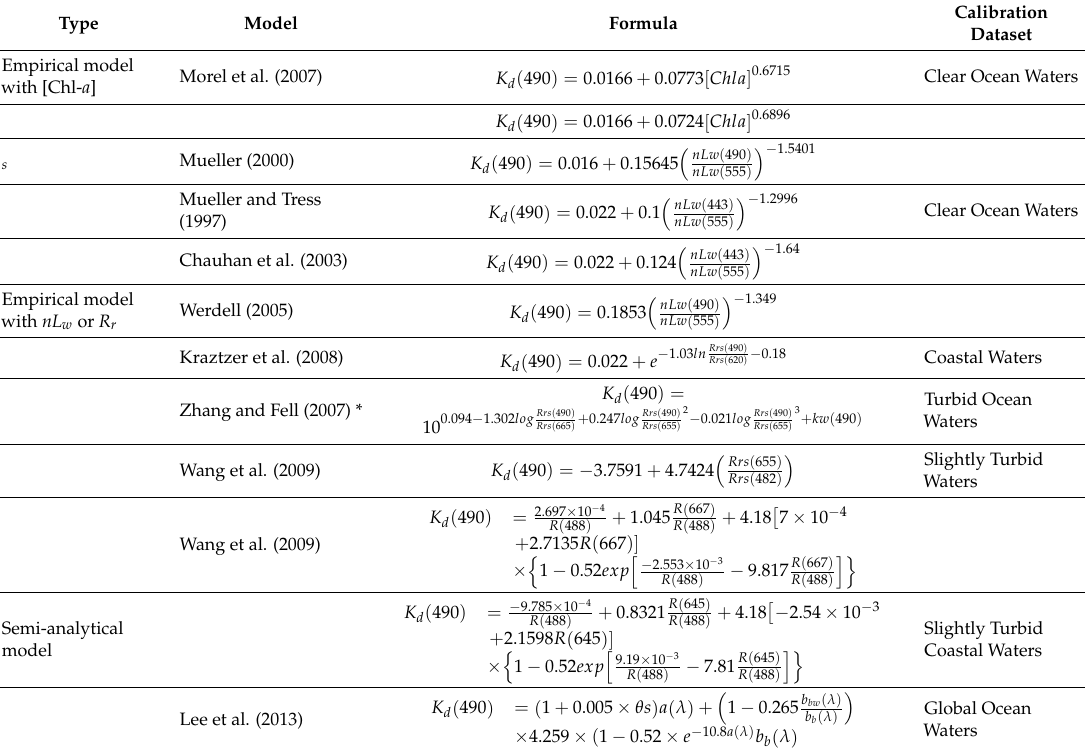
Table 1. k d (490) models developed for clear ocean, coastal, turbid ocean, slightly turbid, and global waters. Although the models were developed to retrieve the k d at 490 nm, we used k d at 482 nm k d (482), which is the nearest wavelength from OLI/Landsat-8; therefore, all models were adjusted to work for k d